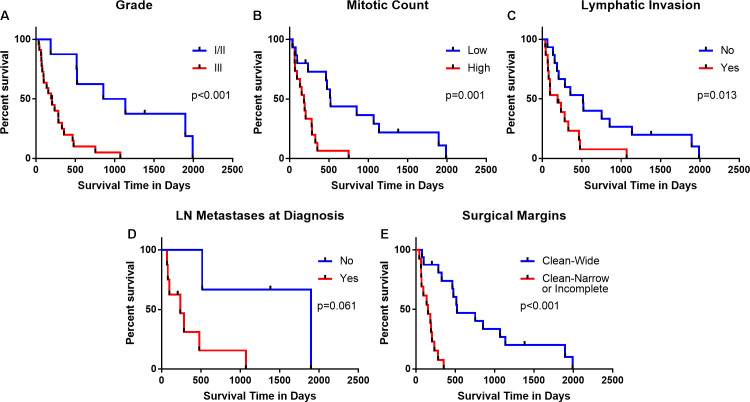
Feline mammary tumor clinical parameters predict outcome.Kaplan-Meier survival curves using cox regression univariate analysis to evaluate whether clinical parameters significantly impacted survival. (A) Grade: I/II vs. III (p<0.001, hazard ratio 2.495, 95%CI 1.493–4.168); (B) Mitotic Count: low (lower than the mean) vs. high (higher than the mean) (p = 0.001, hazard ratio 4.484, 95%CI 1.785–11.262); (C) Lymphatic Invasion: no vs. yes (p = 0.013, hazard ratio 1.658, 95%CI 1.114–2.469); (D) Lymph Node (LN) Metastases at Diagnosis: no vs. yes (p = 0.061, hazard ratio 7.825, 95%CI 0.907–67.532); (E) Surgical Margins: clean-narrow or incomplete vs. clean-wide (p<0.001, hazard ratio 0.302, 95%CI 0.170–0.539).